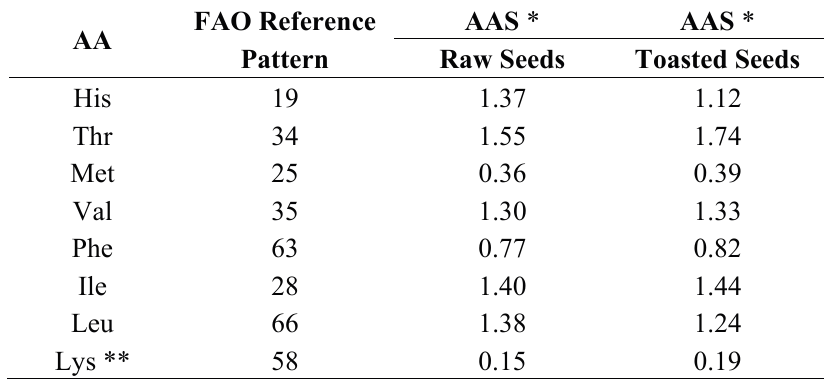
Table 4. Black cherry seeds amino acid score